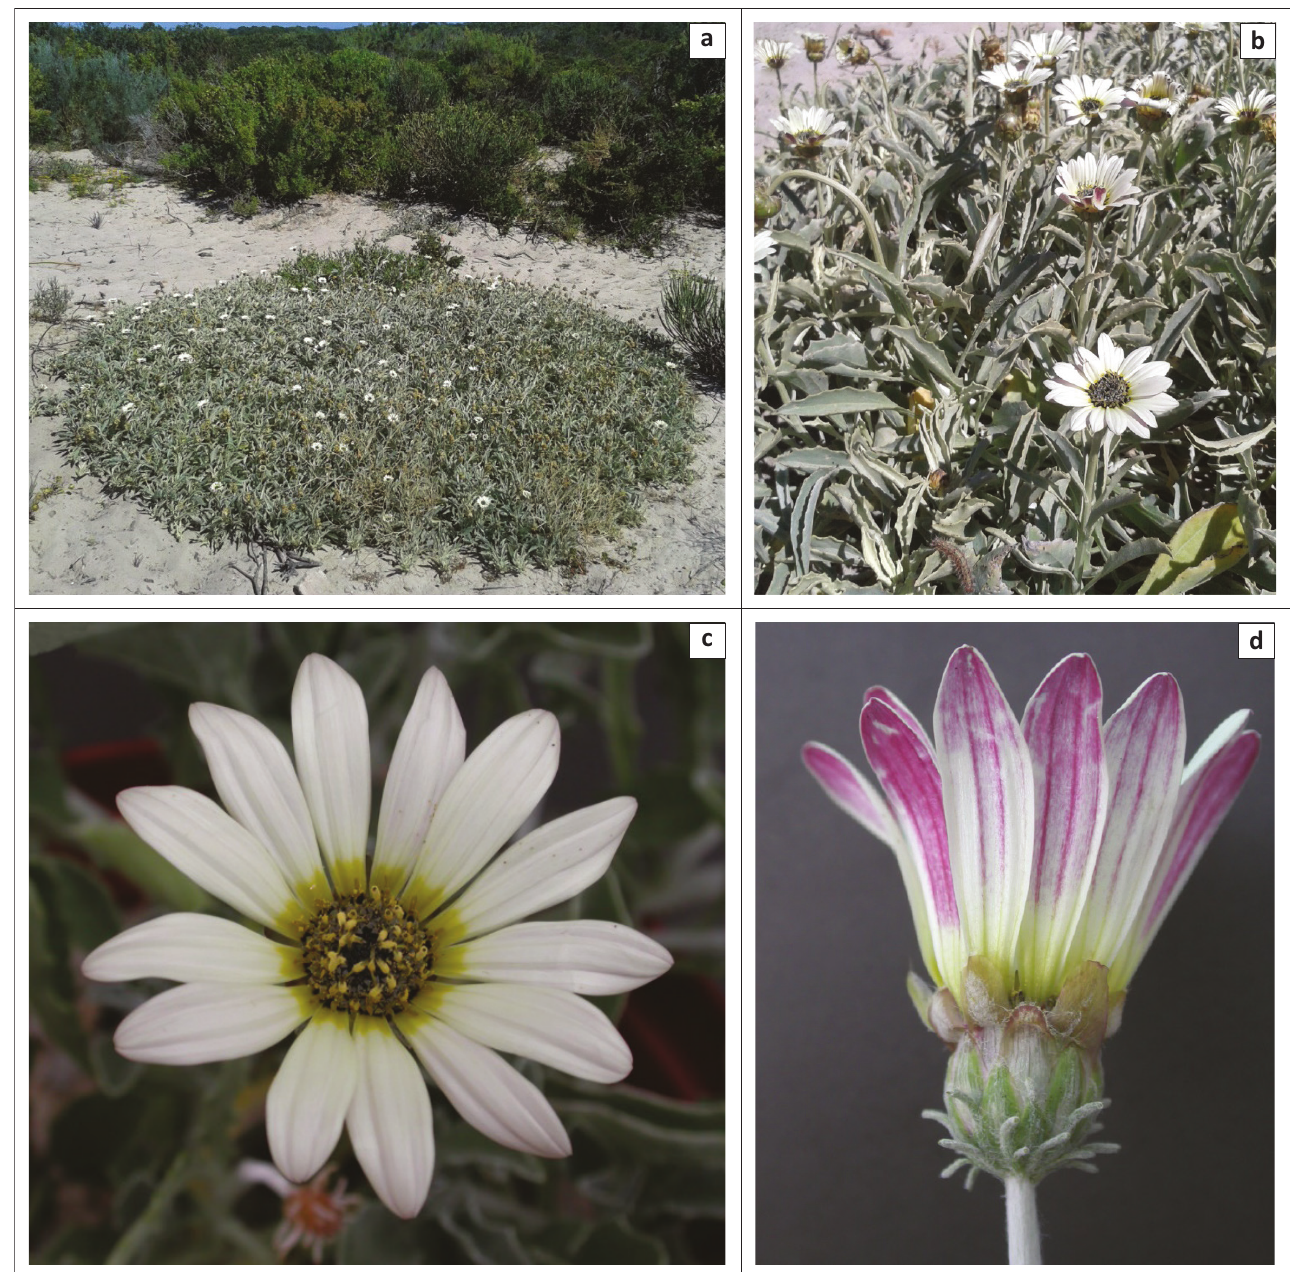
FIGURE 2: Morphology of Arctotis stoechadifolia : (a) and (b) plants at Western Cape, Elandsbaai and (c) and (d) capitula of plants at Western Cape,